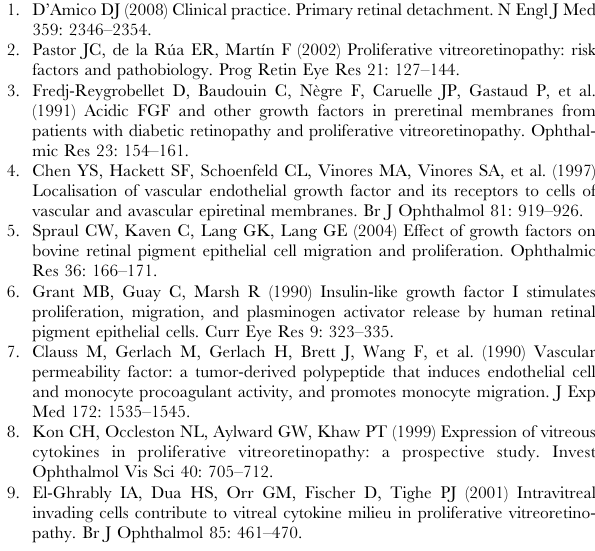
Table S1 Summary of cytokine levels in RRD patients with and without